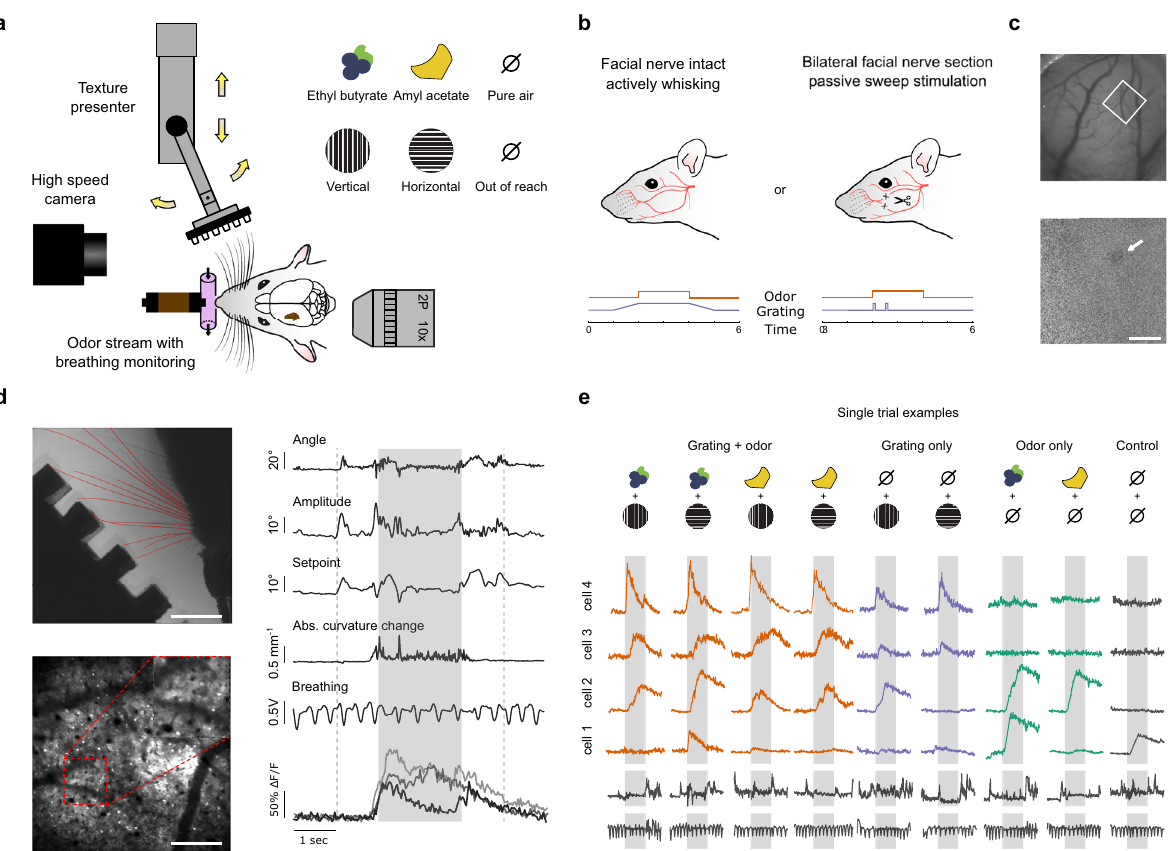
Fig. 1 Calcium imaging in L2/3 of mouse barrel cortex during olfacto-tactile stimulation. a Schematic of olfacto-tactile stimulation setup. A grating was moved in contact with the whiskers in either the vertical or horizontal orientation, while ethyl butyrate or amyl acetate was presented through a constant air stream. Whisking was recorded with high-speed videography (500 Hz) and breathing was monitored with a pressure sensor. b Schematics of the two recording conditions. Left: facial nerve intact, mice whisked freely on the grating brought to their whiskers together with stimulation timing. Right: facial nerve sectioned, the grating was swept on the whiskers while whisking was abolished. c Example of C2 barrel localization with intrinsic signal imaging used to con fi rm the location of GCaMP6s expression in barrel cortex (top: blood vessel image, bottom: intrinsic signal for the same fi eld of view, scale bar: 1 mm, white square: two-photon fi eld of view, arrow: C2 response). d Top left: example frame of whisker pad tracking with the vertical grating at its most extended position (scale bar: 7 mm). Bottom left: image of in vivo GCaMP6s expression in L2/3 (scale bar: 250 µ m). Right: example of simultaneously recorded whisker pad kinematics, breathing, and raw Δ F/F 0 traces. Dashed lines indicate onset and offset of grating approach; gray shading indicates the epoch of stimulation during which odors were present in the air stream. e Illustration of the nine combinations of tactile and olfactory stimuli with single- trial example Δ F/F 0 traces from four neurons showing olfactory responses in the active